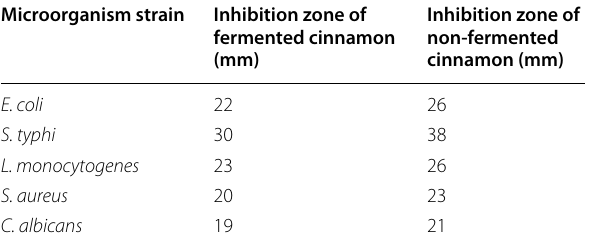
Table 4 Antioxidant activity, total phenols, and flavonoids contents of lyophilized fermented and non‑fermented cinnamon Table 5 Inhibition zone diameters of fermented and non‑ Radical scavenging activity Non‑ fermented lyophilized cinnamon extracts against some fermented cinnamon ABTS radical‑scavenging activity (%)